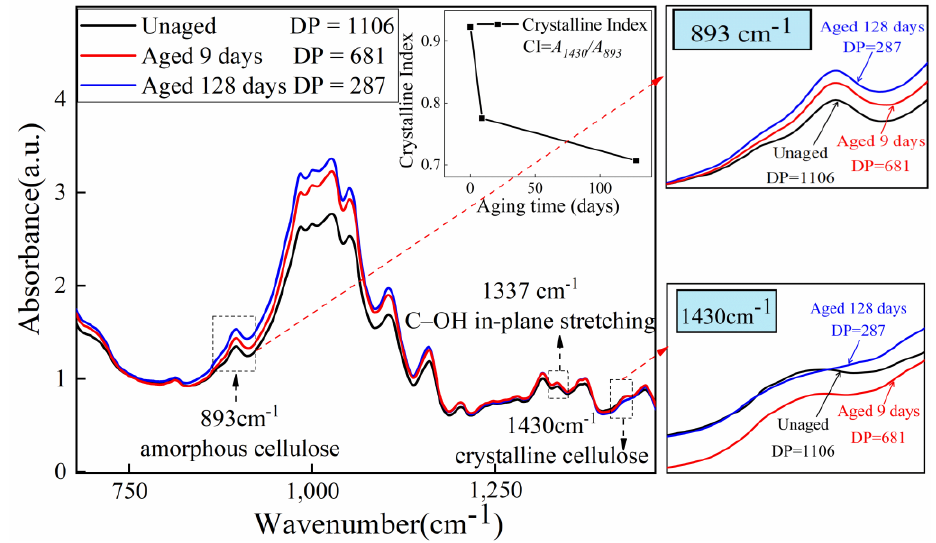
Figure 10. FTIR spectra of insulating paper aged 0, 9, and 128 days including the 893, 1337, and 1430 cm −1 bands. 1430 cm − 1